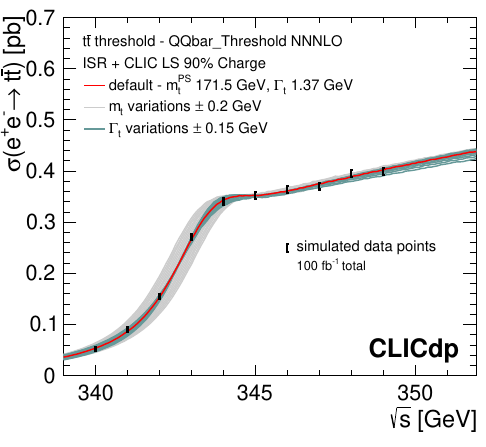
Figure 1 . Illustration of a top-quark threshold scan at CLIC with a total integrated luminosity of 100 fb − 1 . The bands around the central cross section curve show the dependence of the cross section on the top-quark mass and width, the error bars on the simulated data points show the expected statistical uncertainties of the cross section measurement. Figure taken from